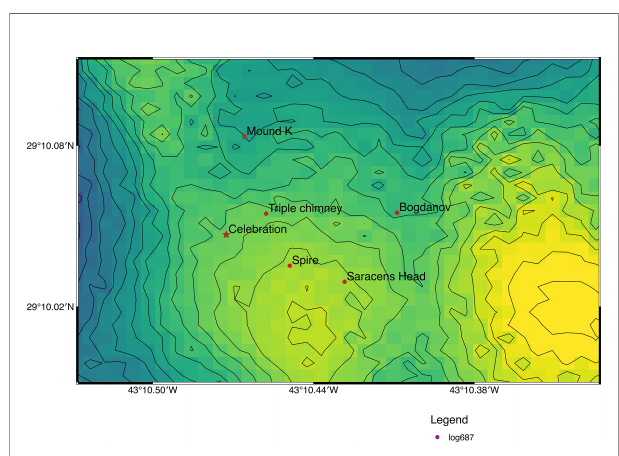
FIGURE 1 | Map of the location of the collection site in the Broken Spur vent fi eld (Map prepared with Q-GIS 2.18.20. Bathymetry and vent fi eld positions from the TRANSECT cruise (Le Bris and the TRANSECT science party, 2018;